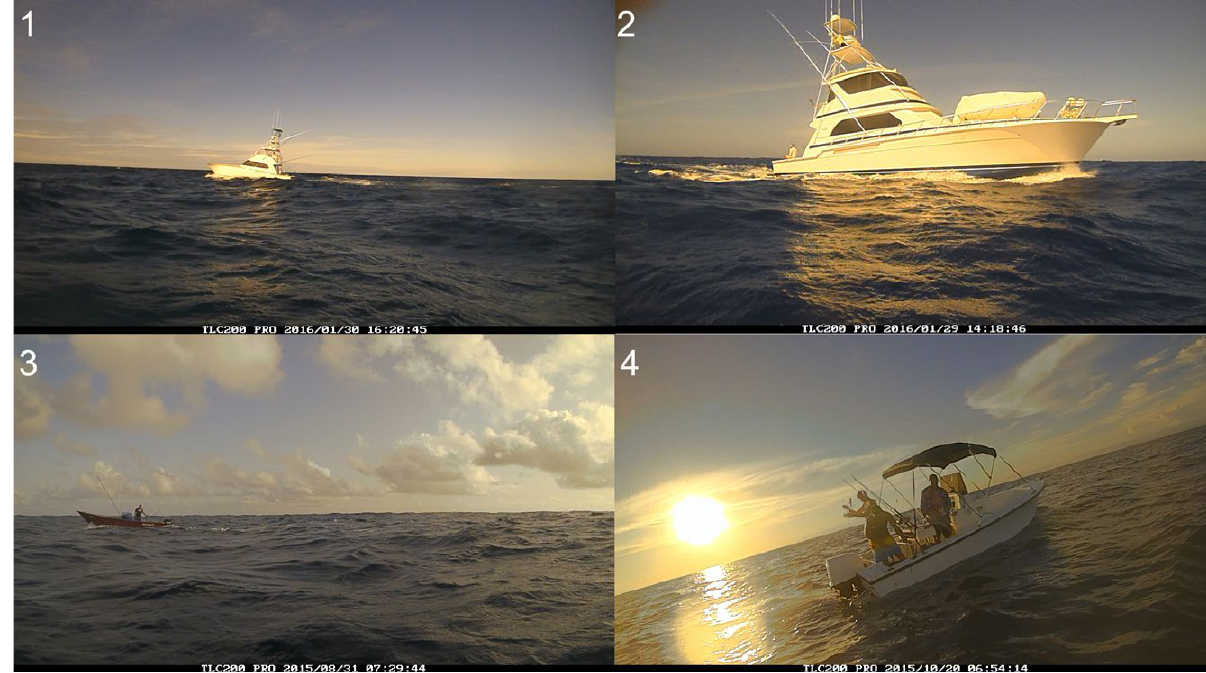
Fig. S3. – Clockwise from upper left: (1) Vessel #89 known charter vessel trolling; (2) Vessel #132 likely recreational vessel trolling named “g_yacht_blue_pin_strips_dbl_window”; (3) Vessel #9 known commercial vessel trolling; (4) Vessel #23 likely recreational vessel drift fish- ing with handlines named